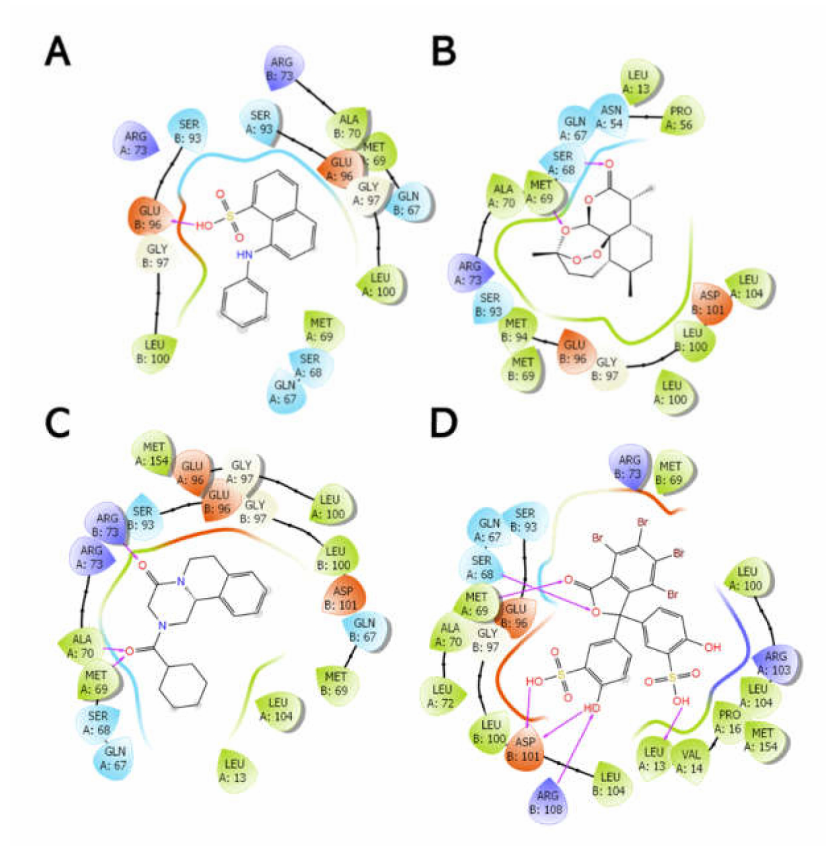
Figure 9. Two-dimensional interaction diagrams between the Sbh26GST dimer interface amino acids and hydrophobic molecules, namely, ANS ( A ), ART ( B ), PZQ ( C ), and BSP ( D ). The purple lines represent H-bond interactions. This image was generated using the ligand interaction diagram implemented in Maestro